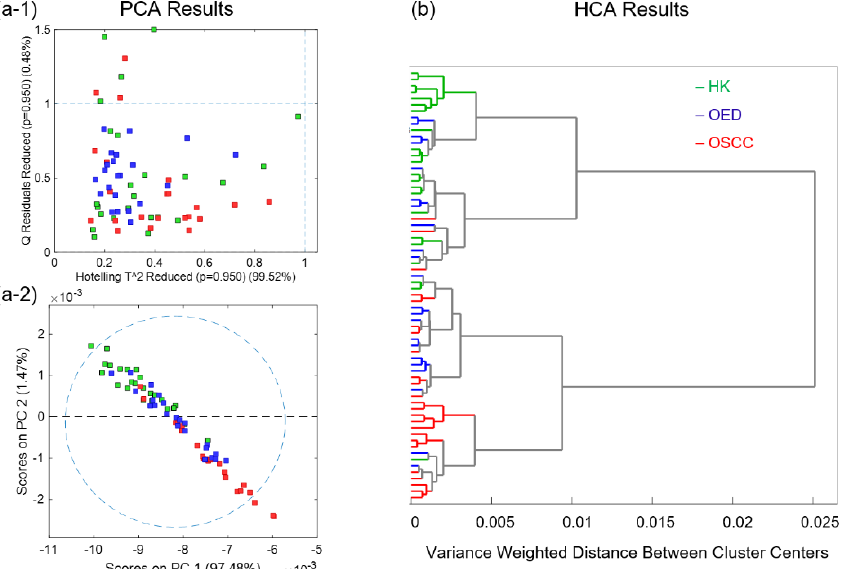
Figure 3. Three class-average spectra after general preprocessing for HK (green), OED (blue), and OSCC (red) samples, with visible spectral differences highlighted in dashed boxes.